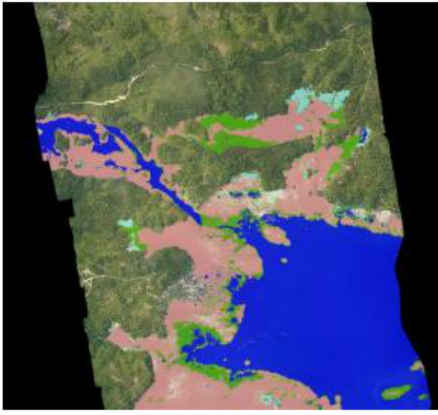
Figure 15. Blk66L021 (Overall Accuracy: 97.3 % KIA: 96.5 %)